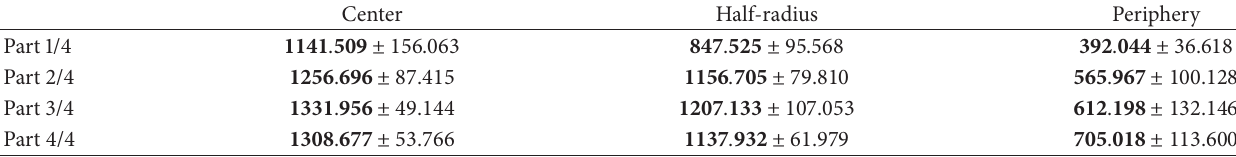
Table 1: Average rate of water absorption and standard deviation of the Raffia vinifera pith.